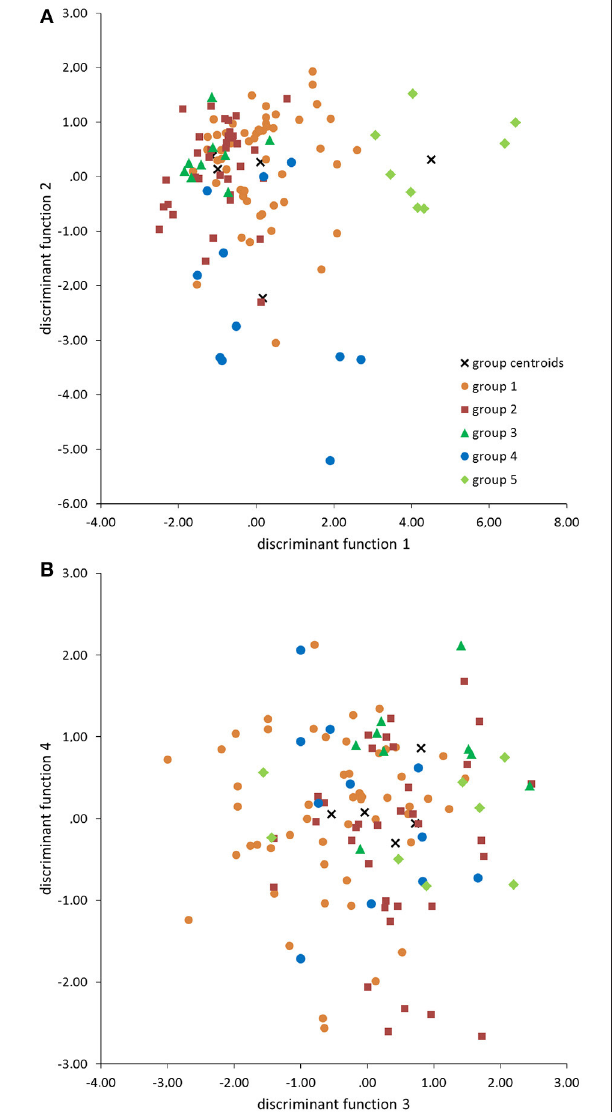
TABLE 2 | Results of the U-statistics (Wilks’ Lambda-method).